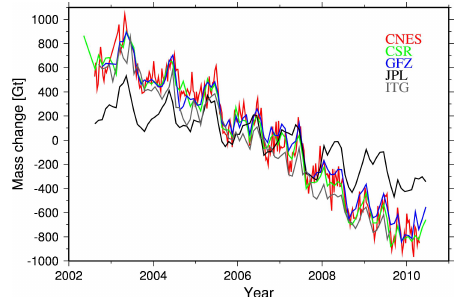
Fig. 4. Observed Greenland mass change over the last decade. Time series of GrIS (Greenland Ice Sheet) from GFZ (GeoForschungs Zen- trum), CSR (Center for Space Research), JPL (Jet Propulsion Lab- oratory), CNES (Centre National d’Etudes Spatiales) and ITG (The Institute of Theoretical Geodesy). Figure credit: Sørensen (2010).